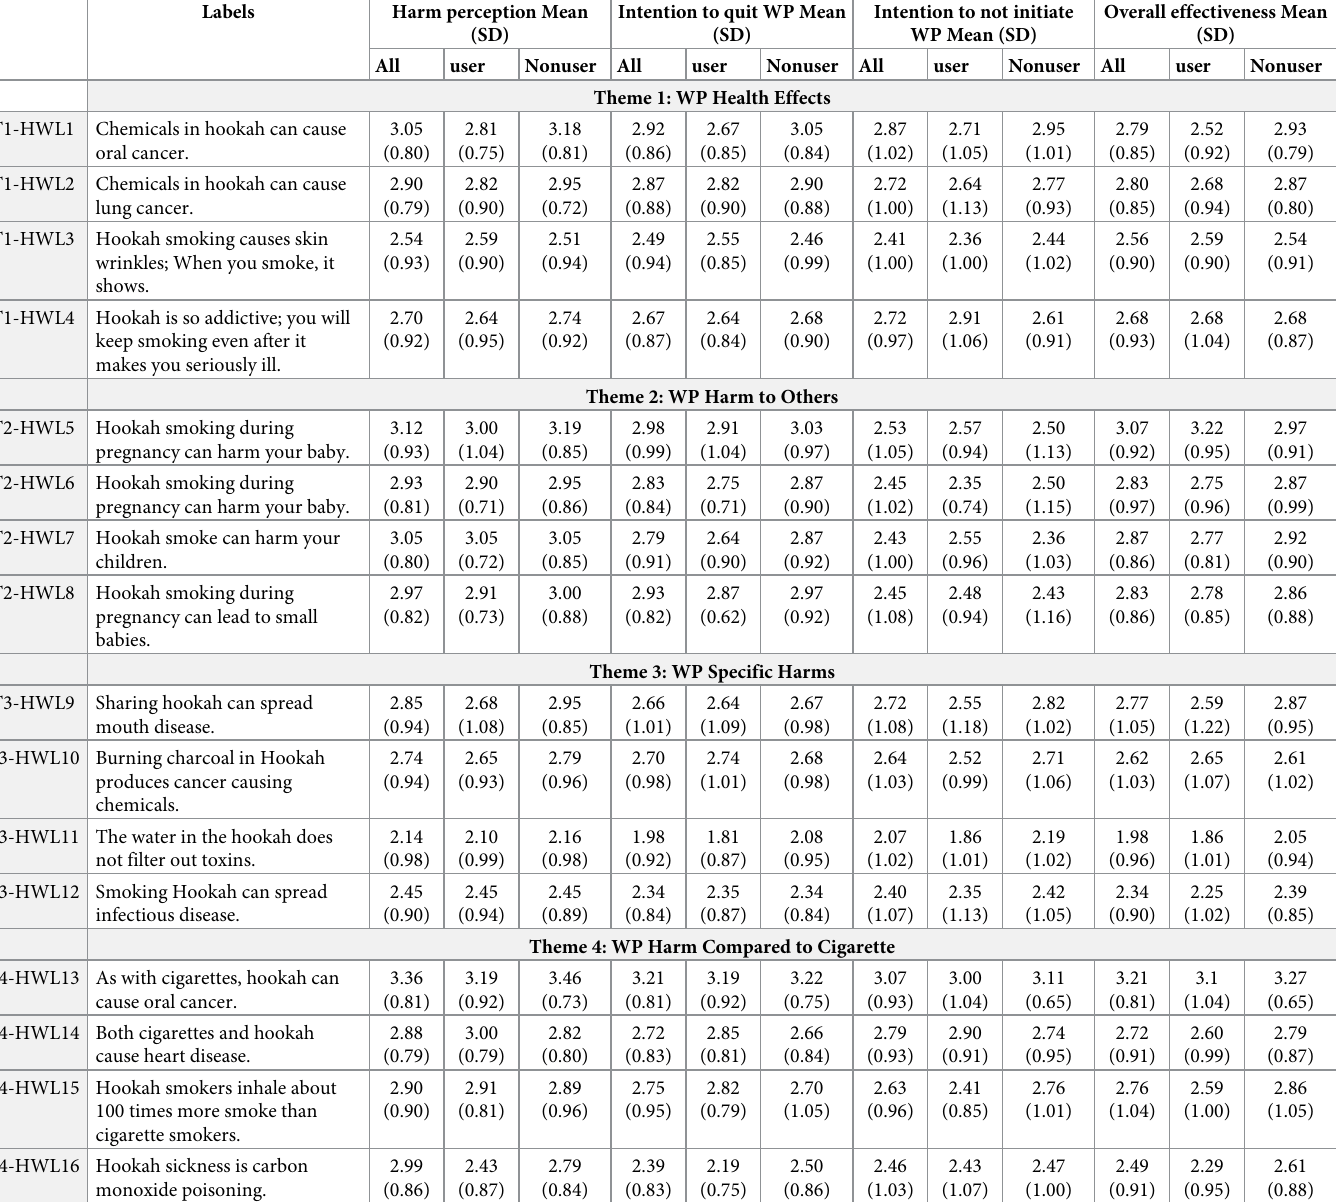
Table 2. Health warning labels rating on harm perception, intention to quit waterpipe, intention to not initiate waterpipe use, and overall effectiveness stratified by themes and waterpipe use. Labels Harm perception Mean